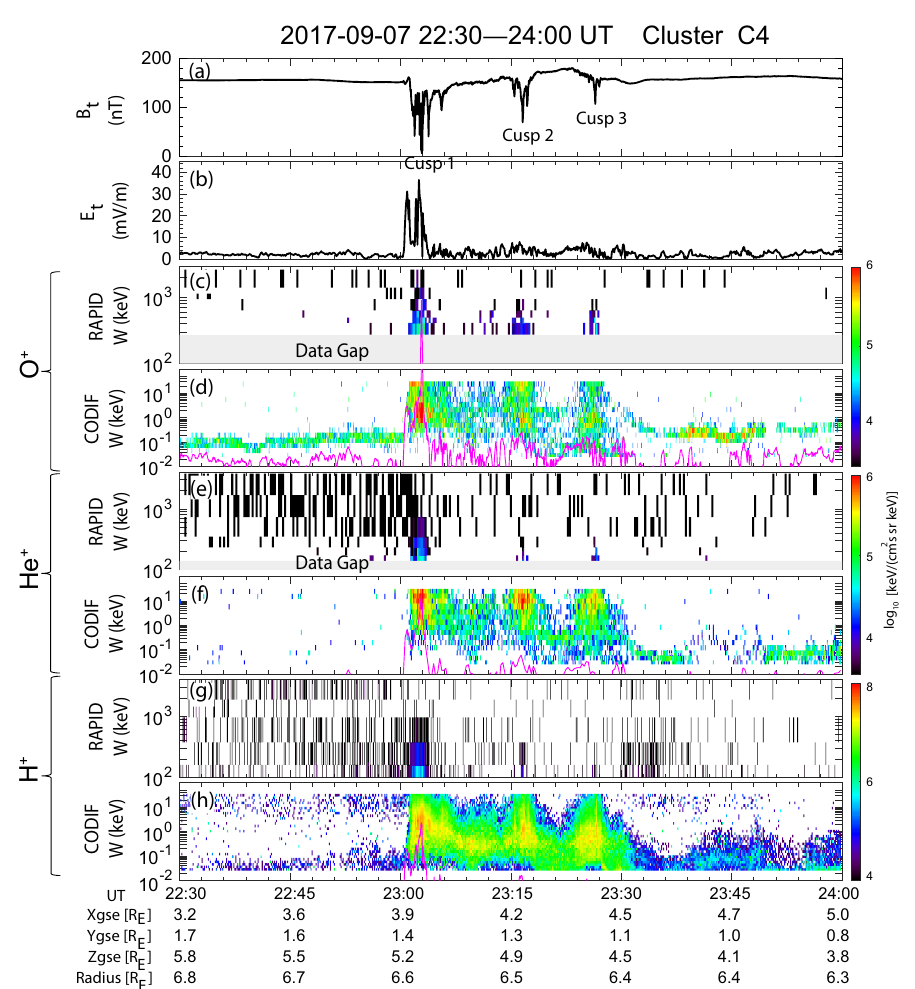
Figure 3. ( a ) Total magnetic field; ( b ) Total electric field; ( c , d ) O + spectra from the RAPID and CODIF instruments, respectively; The same format as panels b-c except for ( e , f ) He + and ( g , h ) H + . The pink line over-plotted on the ion spectrum is the energy increase caused by electric field, estimated with Equation (1). The vertical dashed line represents the shock arrival